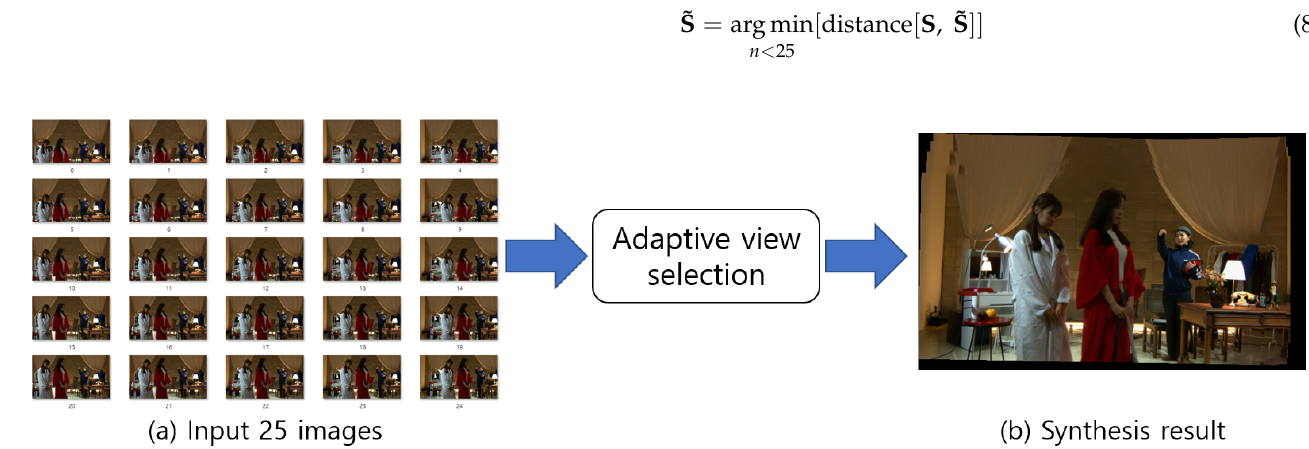
Figure 8. Flow diagram of the proposed approach to view synthesis with adaptive view selection. ( a ) Input: 25 images. ( b ) Synthesized result using selected